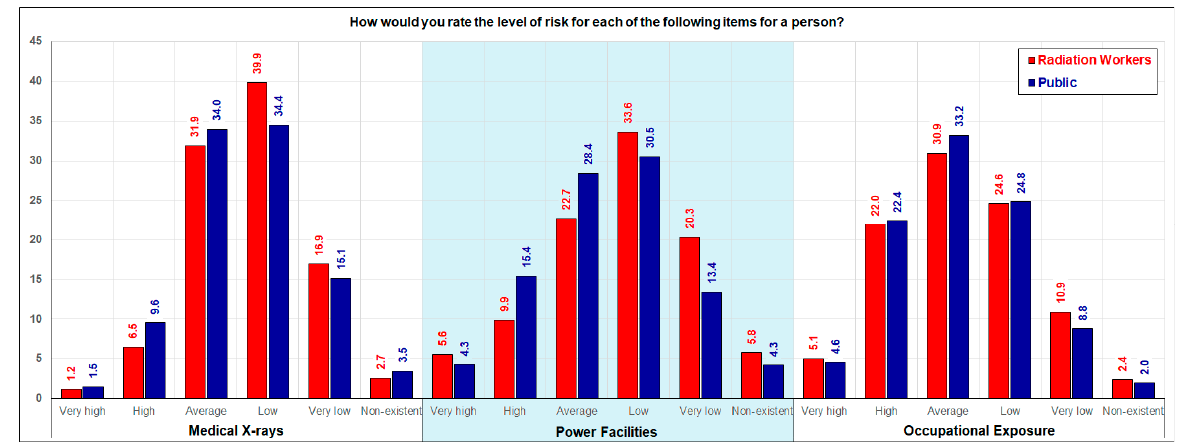
Figure 1. Radiation worker and public ranking of the level of risk for medical X-rays, power facilities, and occupational exposure.